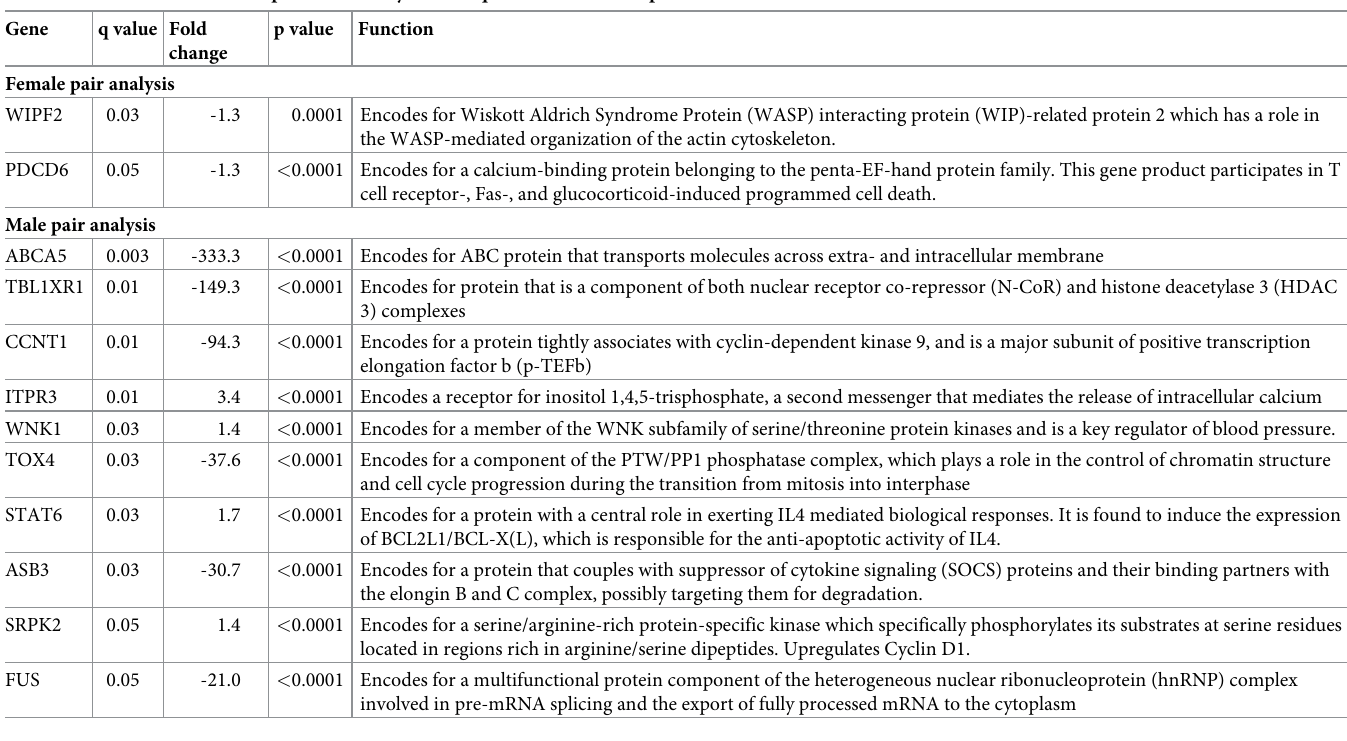
Table 3. Placental RNA transcripts identified by RNA-Seq with differential expression (cid:3) . Gene q value Fold